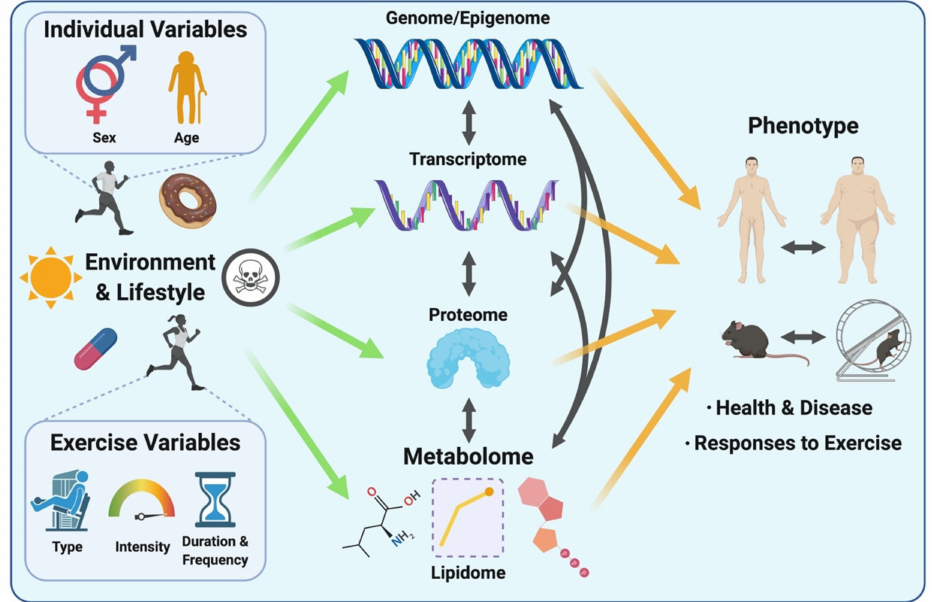
Figure 1. The complex interrelations between biological layers (from the genome/epigenome, tran- scriptome and proteome to the metabolome) and other individual factors (sex and age, environment and lifestyle including exposure to toxins and pollutants (symbolized by skull and crossbones), medication use, dietary habits, . . . ) and exercise variables, and how these biological networks and variables contribute to the overall phenotype. Environmental exposures and lifestyle, including diet and medication, as well as exercise and its associated variables (exercise type, intensity, duration and frequency) can affect all layers of biological regulation and lead to distinct phenotypic signatures in mammalian systems that reflect health, disease and responses to exercise. Adapted from